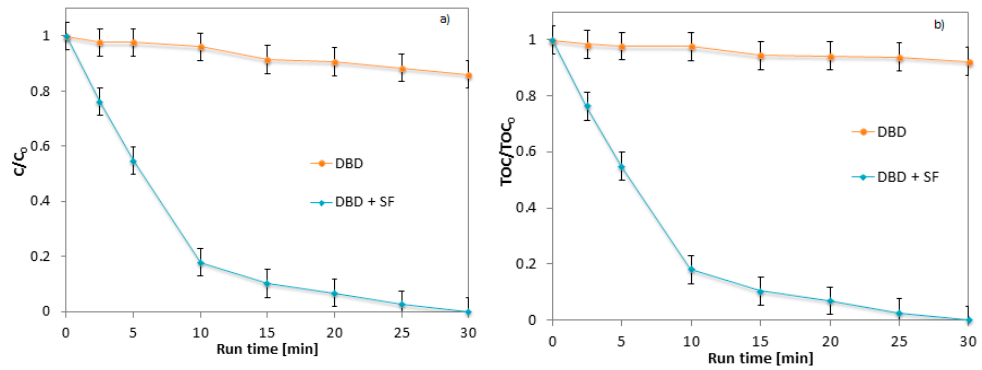
Figure 3. Influence of packed material (glass spheres “SF”) on the efficiency of dielectric barrier discharge (DBD) reactor for AO7 degradation: discoloration ( a ) and mineralization ( b ) behavior during the run time. AO7 initial concentration: 20 mg/L. Glass spheres amount: 36 g. Applied voltage: 12 kV. O 2 flow rate: 0.18 NL/min.